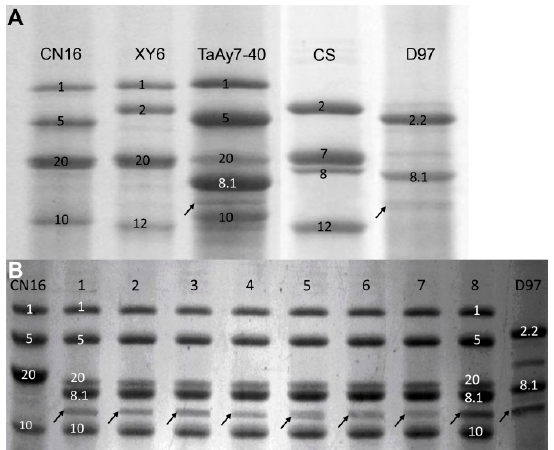
Figure 2. SDS-PAGE analysis of high molecular weight glutenin subunits (HMW-GSs). ( A ) HMW-GSs’ identification of the introgression line TaAy7-40 through the parents and the two common wheat cultivars Xiaoyan6 (XY6) (1Ax1, 1Bx20 + 1By20, 1Dx2 + 1Dy12) and Chinese Spring (CS) (1Bx7 + 1By8, 1Dx2 + 1Dy12) as the references. ( B ) HMW-GSs’ composition and stability of TaAy7-40. Lanes 1–8: eight randomly sampled grains of TaAy7-40.The 1Ay subunits are marked by arrows.